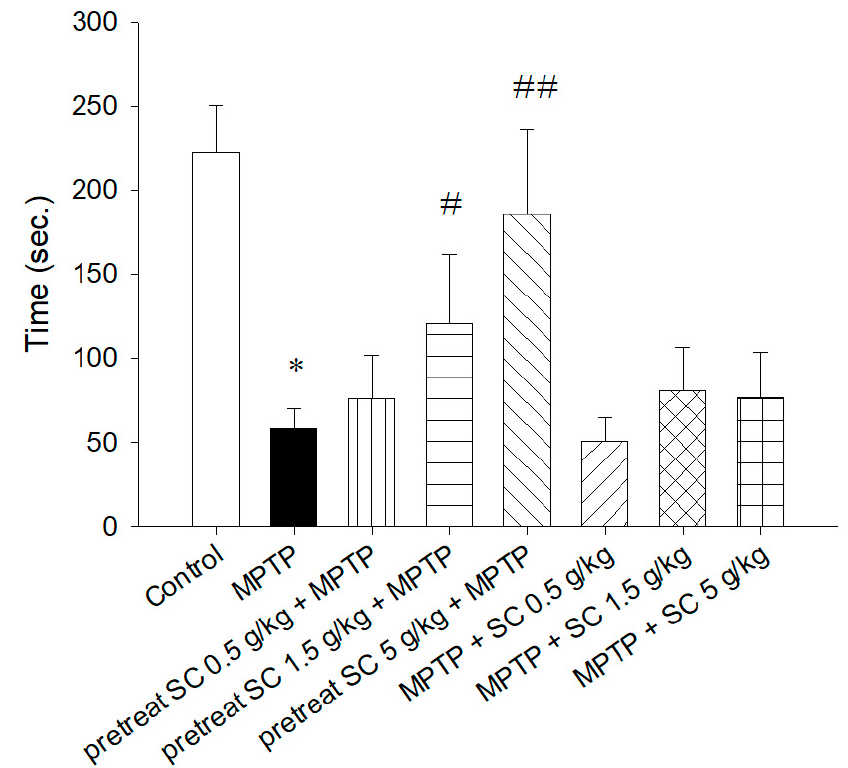
Figure 3. Rotarod performance in different experimental groups. The data are expressed as the mean ± SD. * p < 0.001 compared with the control group; # p < 0.005 and ## p < 0.001 compared with the MPTP group as determined by T -tests. MPTP, 1-methyl-4-phenyl-1,2,3,6-tetrahydropyridine; SC: Schisandra chinensis extract.